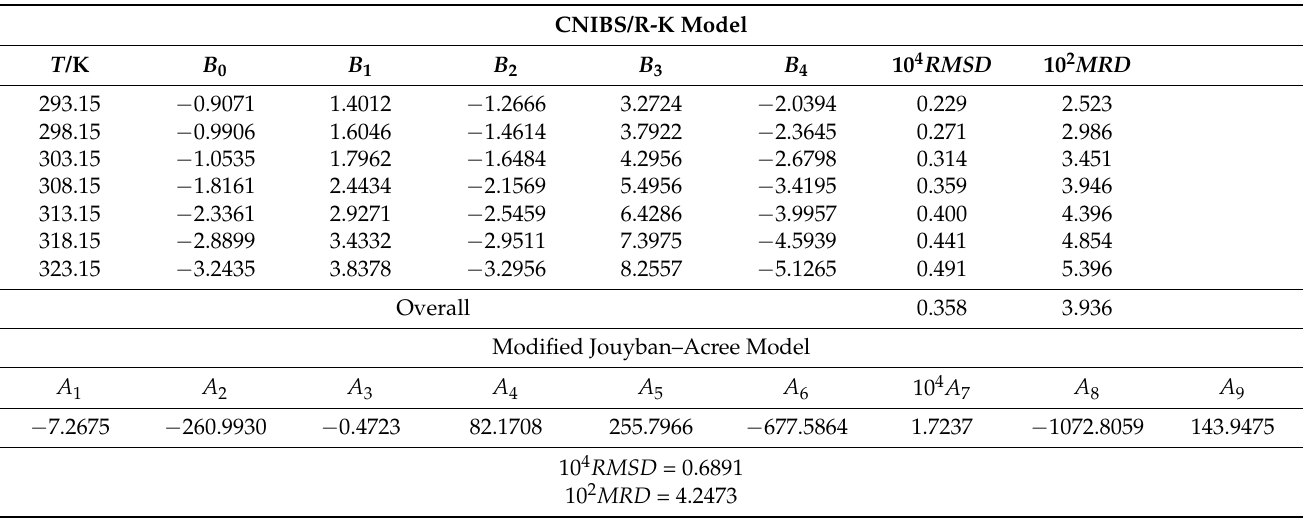
Table 7. Parameters of the CNIBS/R-K model and Jouyban–Acree model for GLN in a 1,4-dioxane